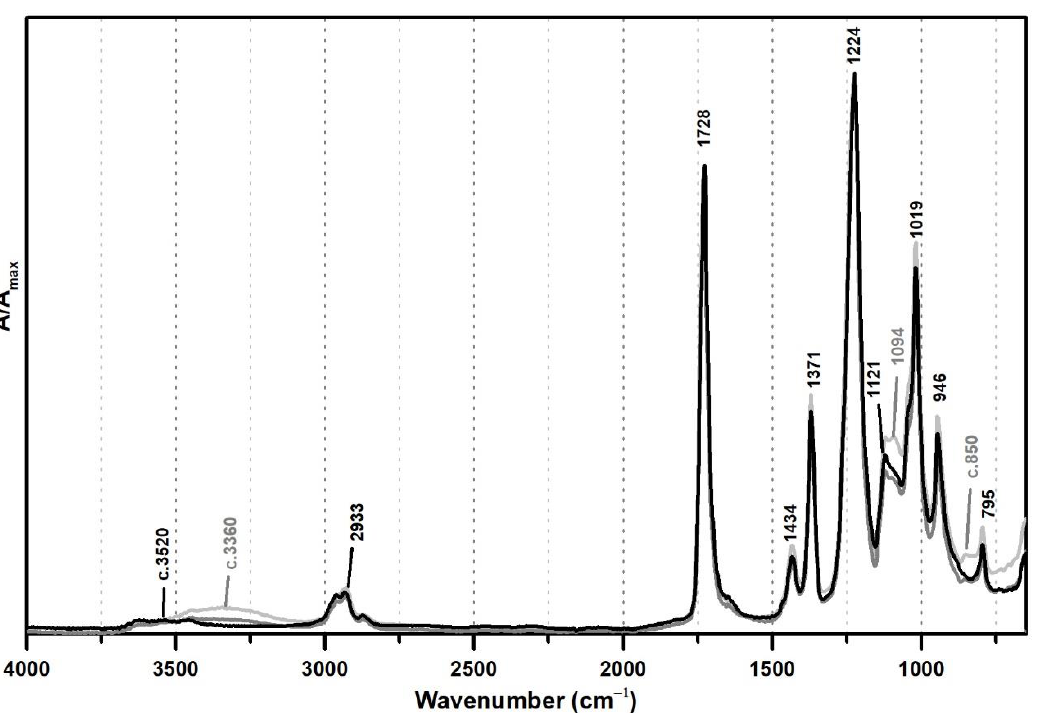
Figure 1. Infrared spectra in ATR of vinyl emulsion films produced for the purpose of this study: pure PVAc (black) and PVAc stabilised with 5% (dark grey) and 10% (light grey) of PVAl.